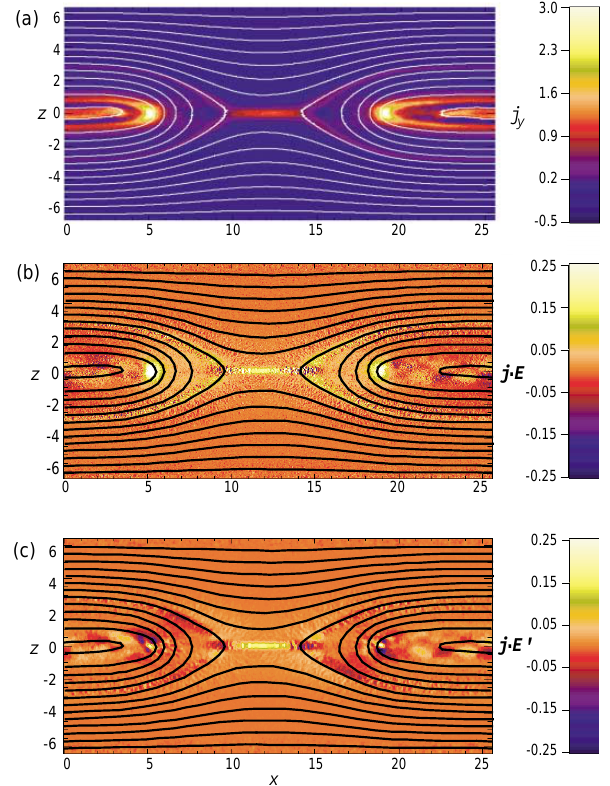
Fig. 6. Particle-in-cell simulations of magnetic reconnection, show- ing (a) current density and magnetic field, (b) load regions, defined by j · E > 0, and (c) Joule dissipation, given by j · E 0 .